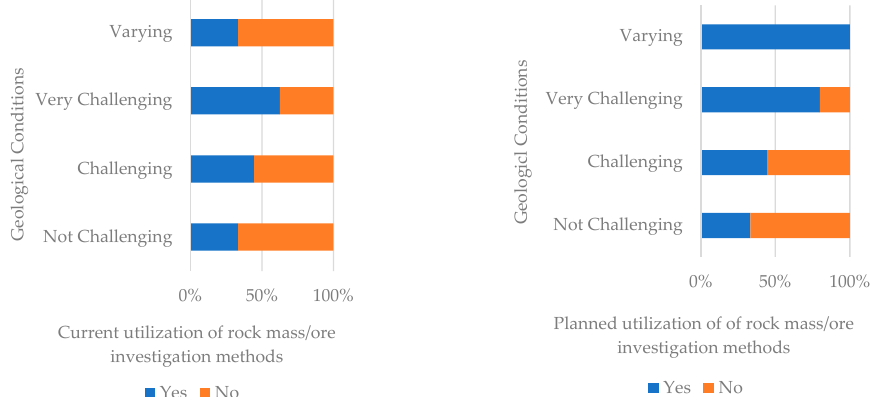
Figure 17. Correlation of the current ( left ) and planned ( right ) utilization of rock mass and ore characterization methods with geological conditions.